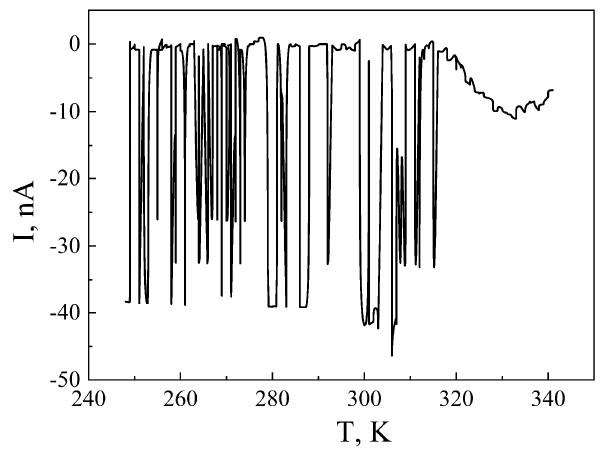
Figure 4. Thermally stimulated discharge currents for MSM-41<SFA> encapsulation.